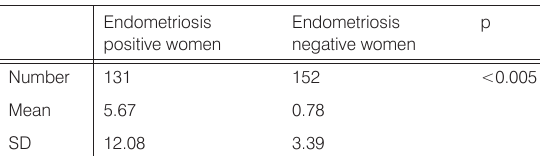
Table 2. Nerve fibre density per mm² in the functional layer of endometrial